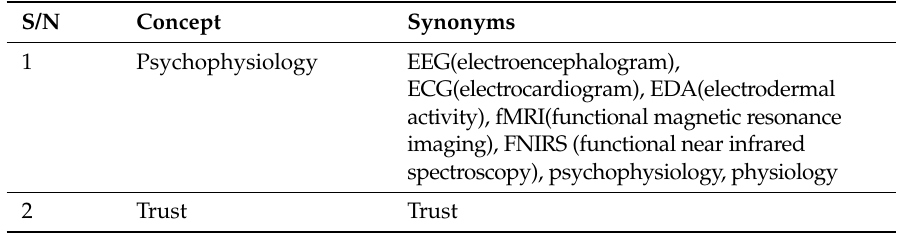
Table 2. Keywords and synonyms.